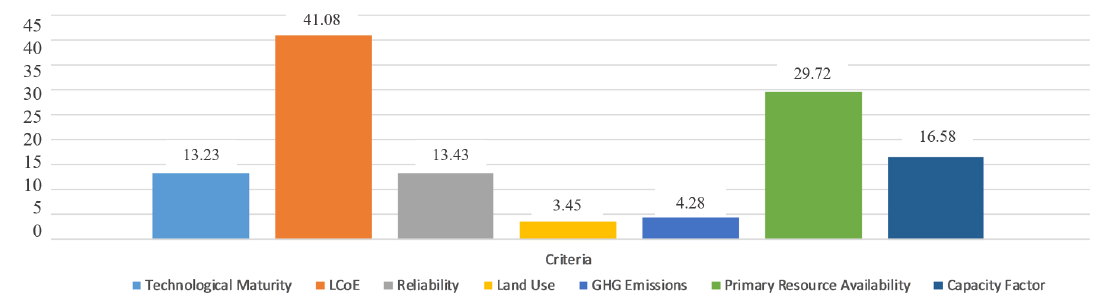
Figure 2. Weighted summed values of the sub-criteria as calculated using the AHP method (R.I. = 1.32, λ max = 6.17) (Table 1).